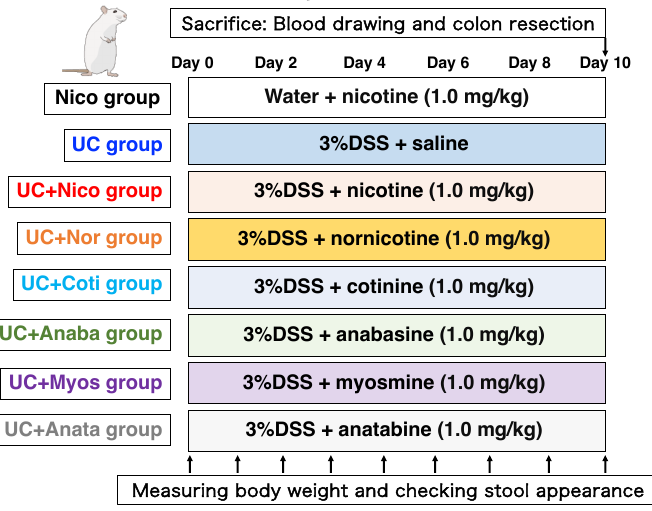
Figure 1. Protocol for animal experiments. Nico group, Slc: Wistar rats (wild-type [WT]) were intraperitoneally administered 1.0 mg/kg nicotine daily; in the UC group, WT rats were orally admin- istered 3% dextran sulfate sodium (DSS), plus an equal volume of saline (1.0 mg/kg)